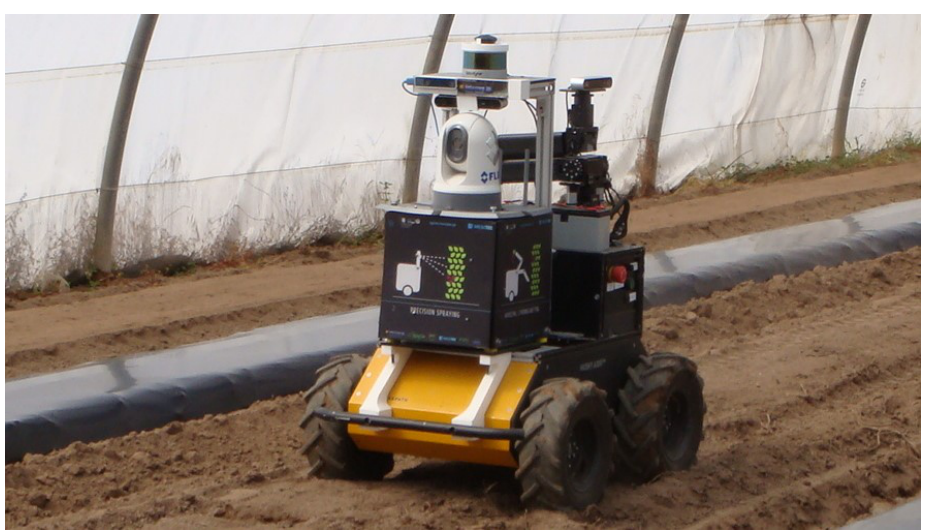
Figure 6. AgRob v16 inside an uncultivated